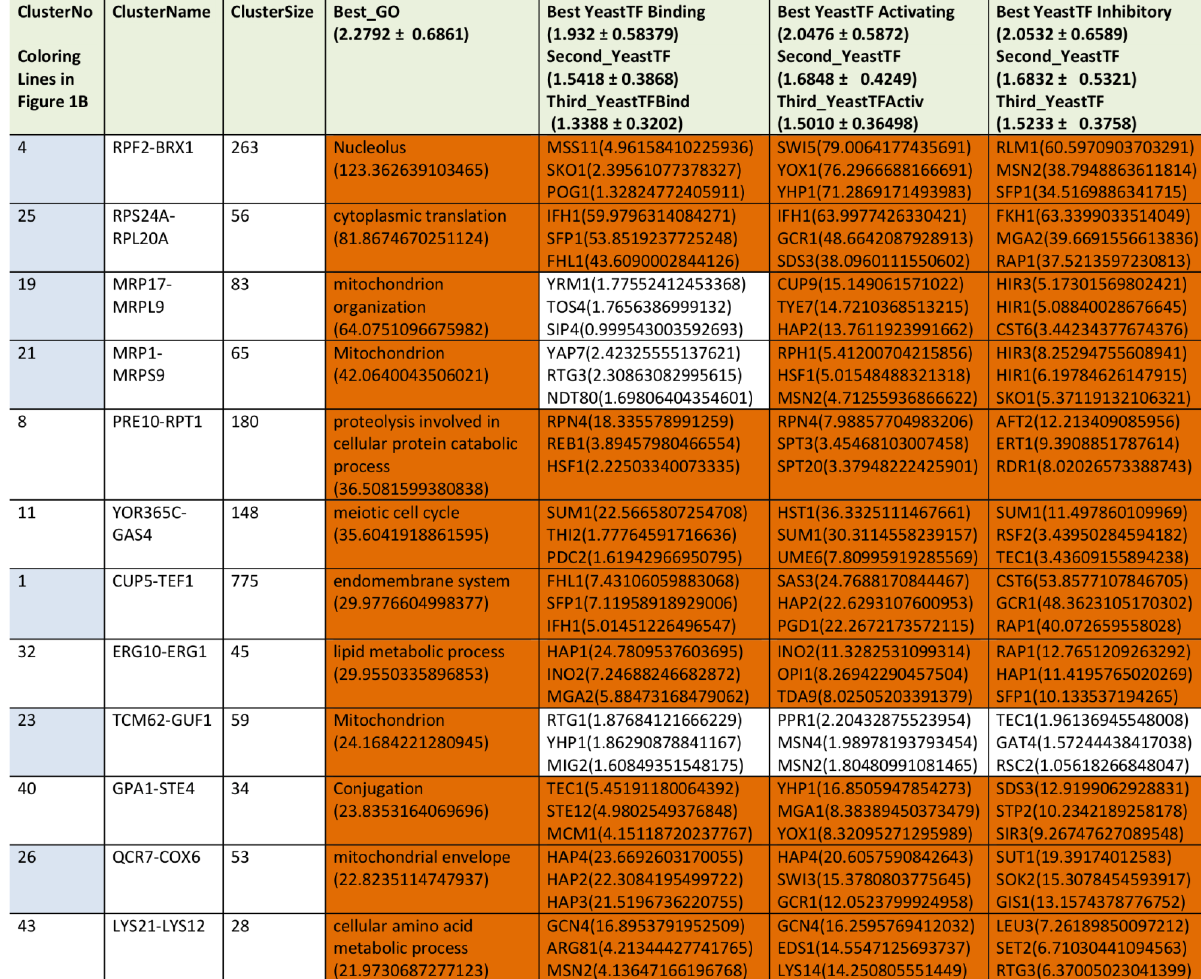
TABLE 1. Most prominent results from